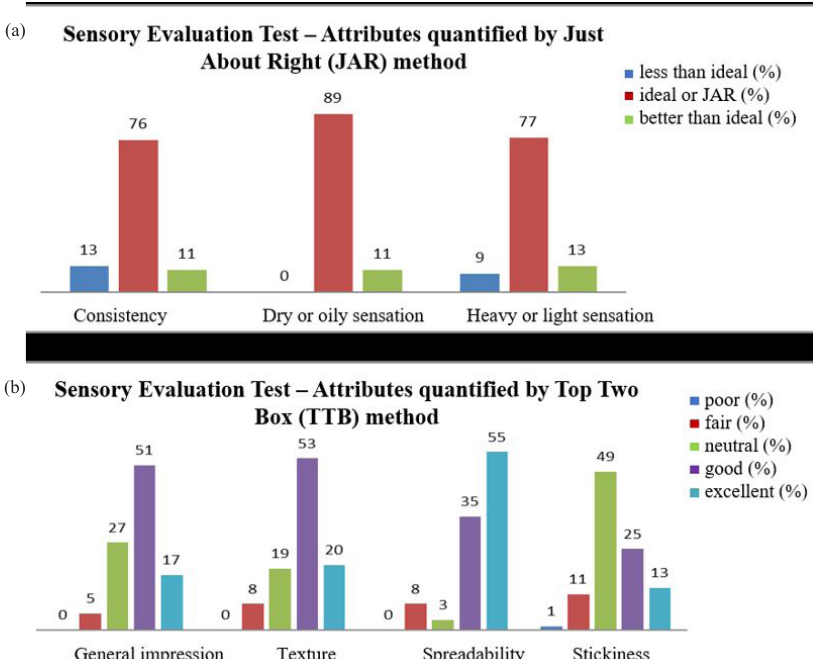
Figure 4. Histograms of attributes quantified by JAR (a) and TTB (b)